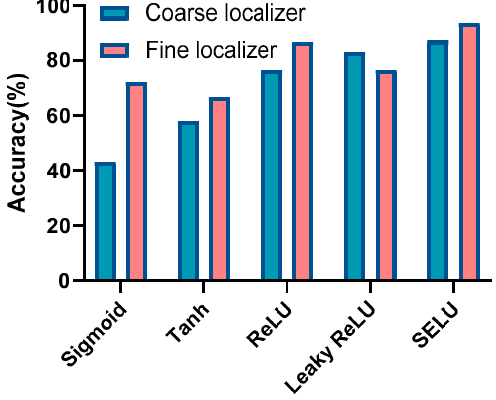
Figure 14. Positioning performance with different numbers of hidden layers.